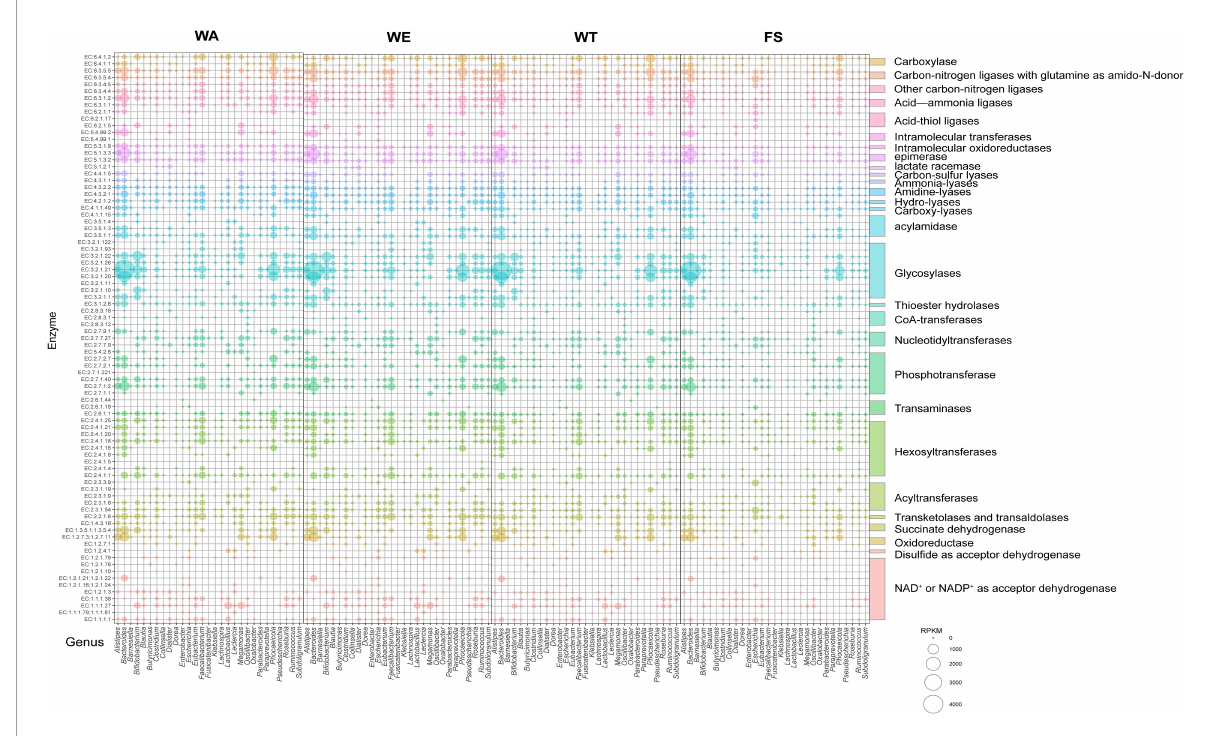
FIGURE6 Microbial taxonomic distribution and enzyme gene abundance of substrate decomposition and metabolite synthesis genes during the fermentation of cereals mixture. The RPKM value of the enzyme encoding gene was proportional to the diameter of the bubble. The vertical coordinate represents the EC number of the functional enzyme. The horizontal axis shows only 29 key genera with relative contributions of functional genes.